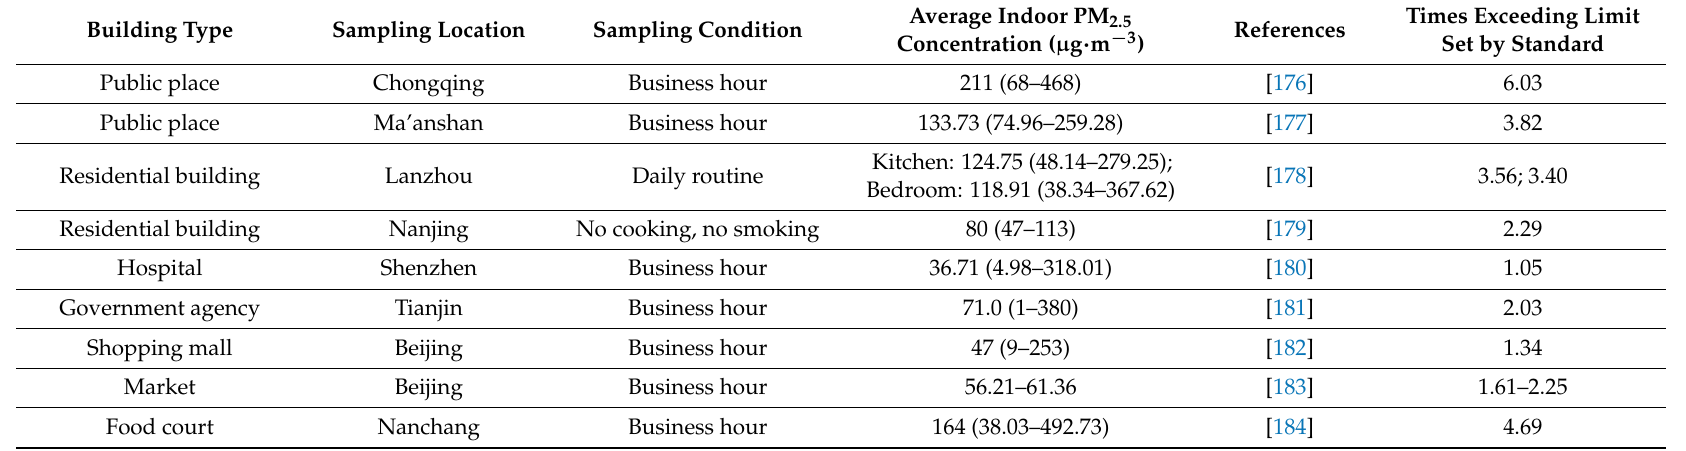
Table 3. Current status of indoor PM 2.5